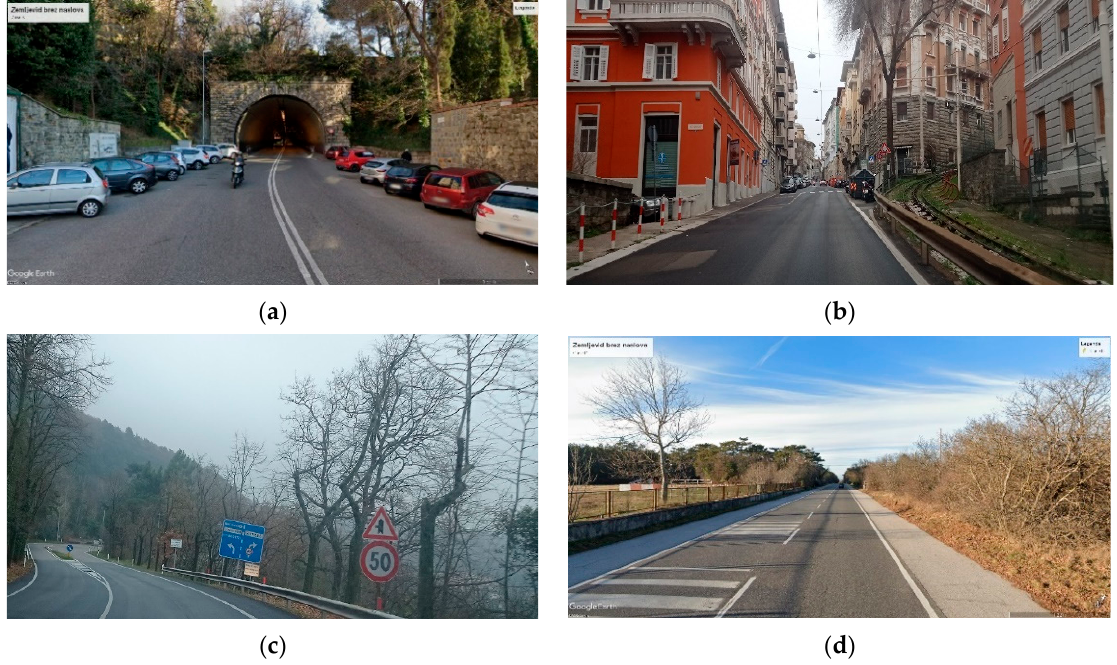
Figure 5. ( a ) Case A: the entrance into the tunnel (45.642059°N, 13.7744820°E); ( b ) Case B: urban canyons in the city centre (45.655748°N, 13.771247°E); ( c ) Case C: serpentines (45.657905°N, 13.813880°E); ( d ) Case D: straight road with vegetation as only barrier (45.690686°N, 13.769906°E).